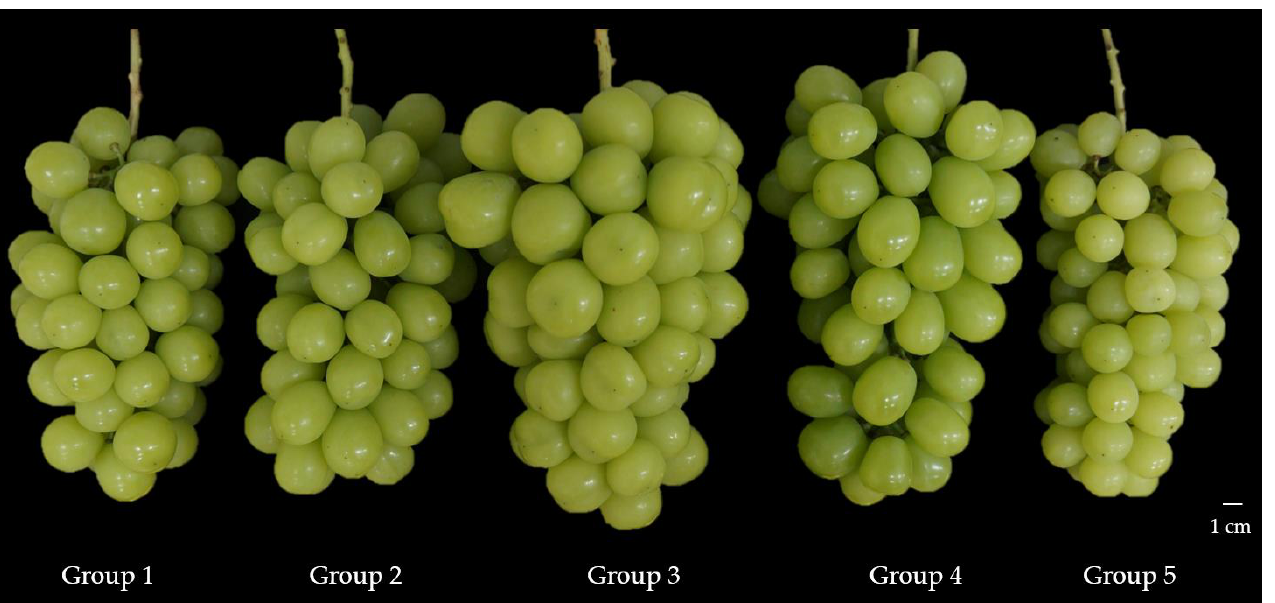
Figure 1. The shape of ‘Shine Muscat’ grapes at harvest according to PGR treatment. The combina- tions of PGR treatments applied at full bloom (F) and 12 days after full bloom (DAFB) are as follows. Group 1: F: GA 3 12.5 + TDZ 2.5, 12 DAFB: GA 3 25. Group 2: F: GA 3 25 + CPPU 5, 12 DAFB: GA 3 25. Group 3: F: GA 3 25 + TDZ 5, 12 DAFB: GA 3 25. Group 4: GA 3 25 + CPPU 5, 12 DAFB: GA 3 25+ CPPU 5. Group 5: F: GA 3 25 + CPPU 5, 12 DAFB: untreated. The numbers that appear with the PGR